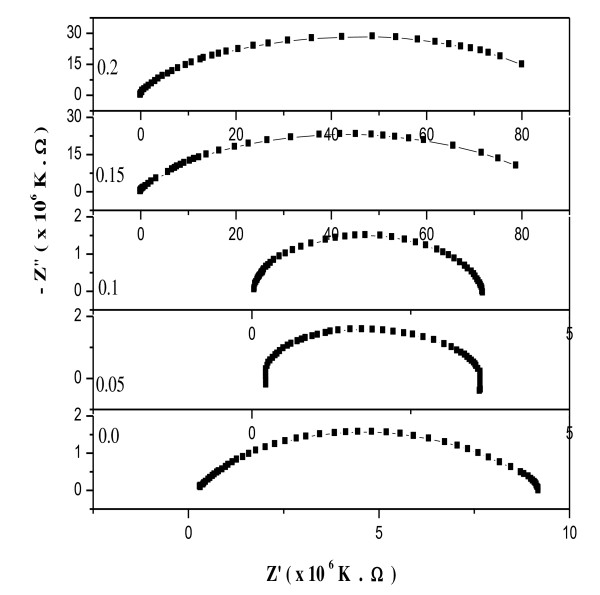
The Cole-Cole plot of Ni0.7-xCu0.3ZnxFe2O4 ferrite nanoparticles at room temperature.